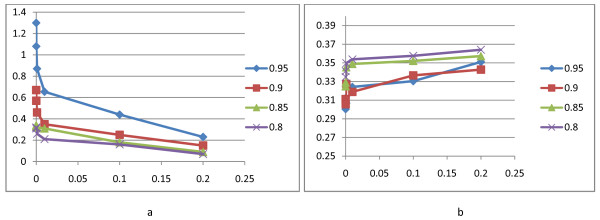
The value of energy function (b) and running time of algorithm (a) for each Tlow for JSA data.